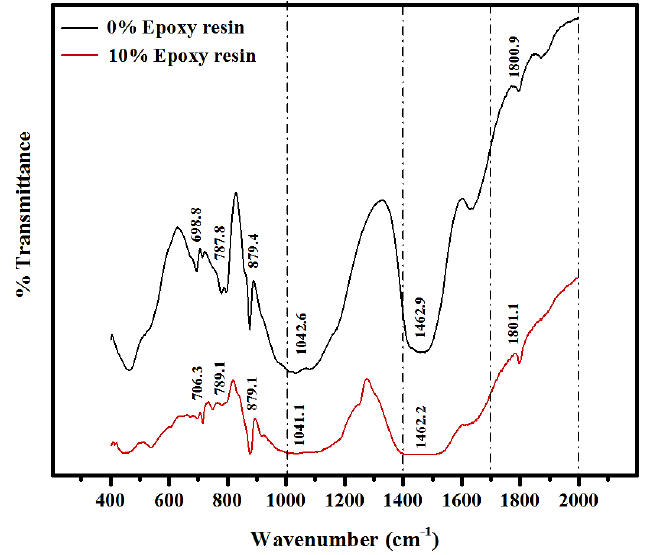
Figure 10. FTIR spectra analysis of the OPC and 10% epoxy resin modified mortar.